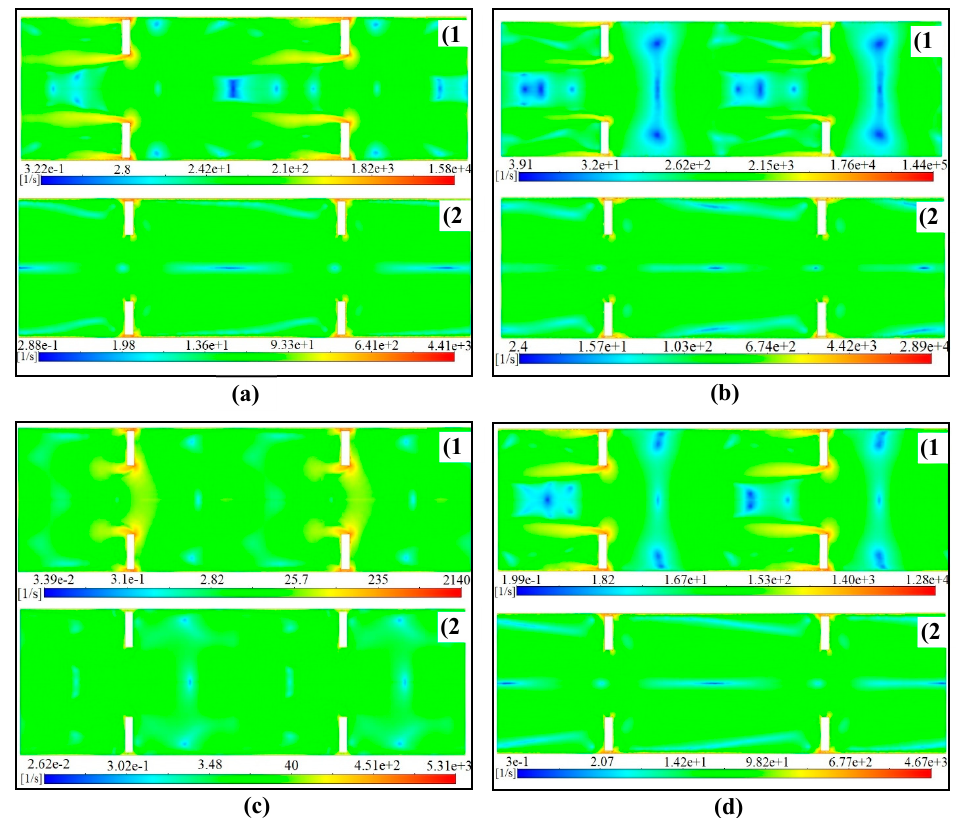
Figure 16. Shear strain rate contour for ( a ) f = 2 Hz and x o = 40 mm, ( b ) f = 10 Hz and x o = 40 mm, ( c ) f = 2 Hz and x o = 6 mm, ( d ) f = 2 Hz and x o = 30 mm (the di ff erent phases of the oscillation cycle are shown in the top corner of each plot). Processes 2020 , 8 , x FOR PEER REVIEW